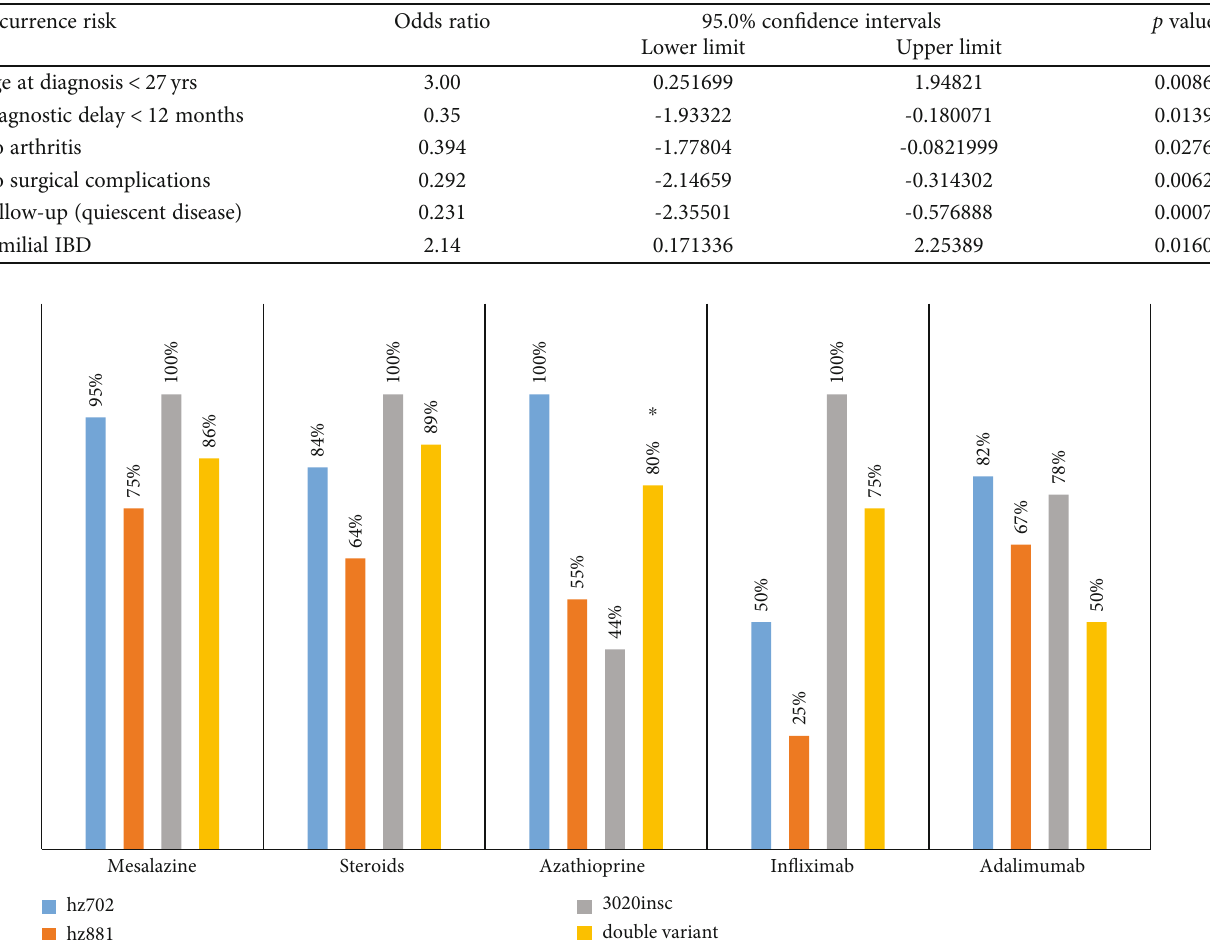
Table 5: Independent variables associated with the surgical recurrence risk.